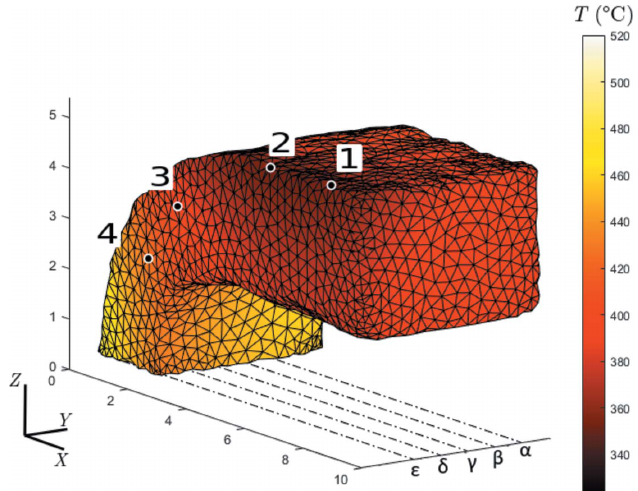
Figure 4 Evolution of the temperature during the rotation at several points on the sample. Each point is hidden during one half of the rotation and by the columns. Values at grazing angles are not considered. Positions of the considered points are plotted in Fig. 5